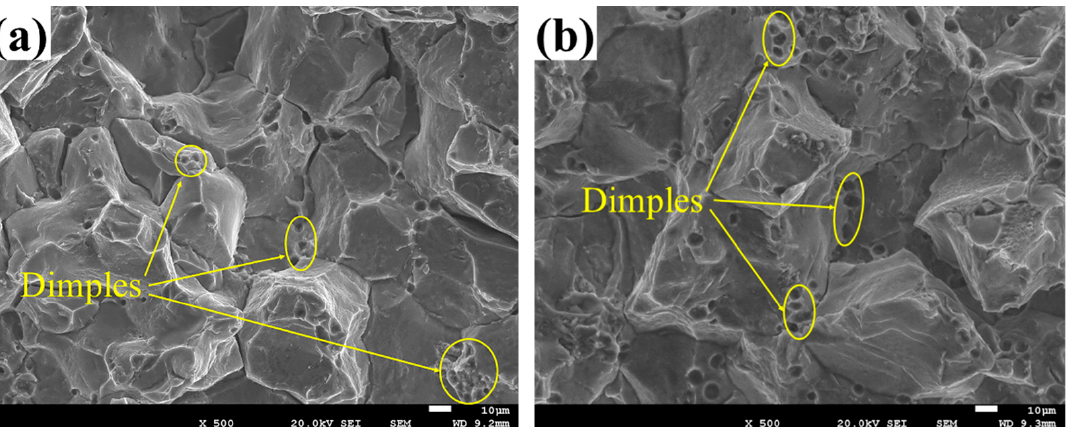
Figure 9. The tensile fracture morphology of squeeze castings under different conditions: ( a ) Without ESMT; ( b ) With ESMT.